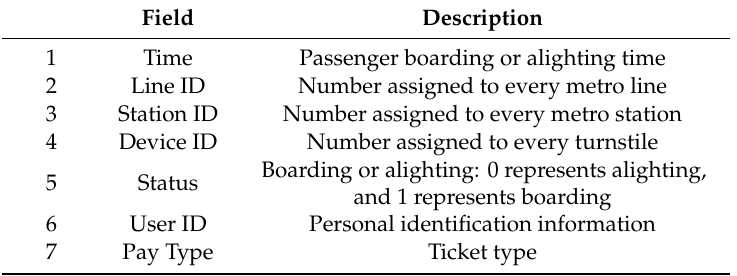
Table 1. Data fields collected from the automatic fare collection (AFC) system of Hangzhou